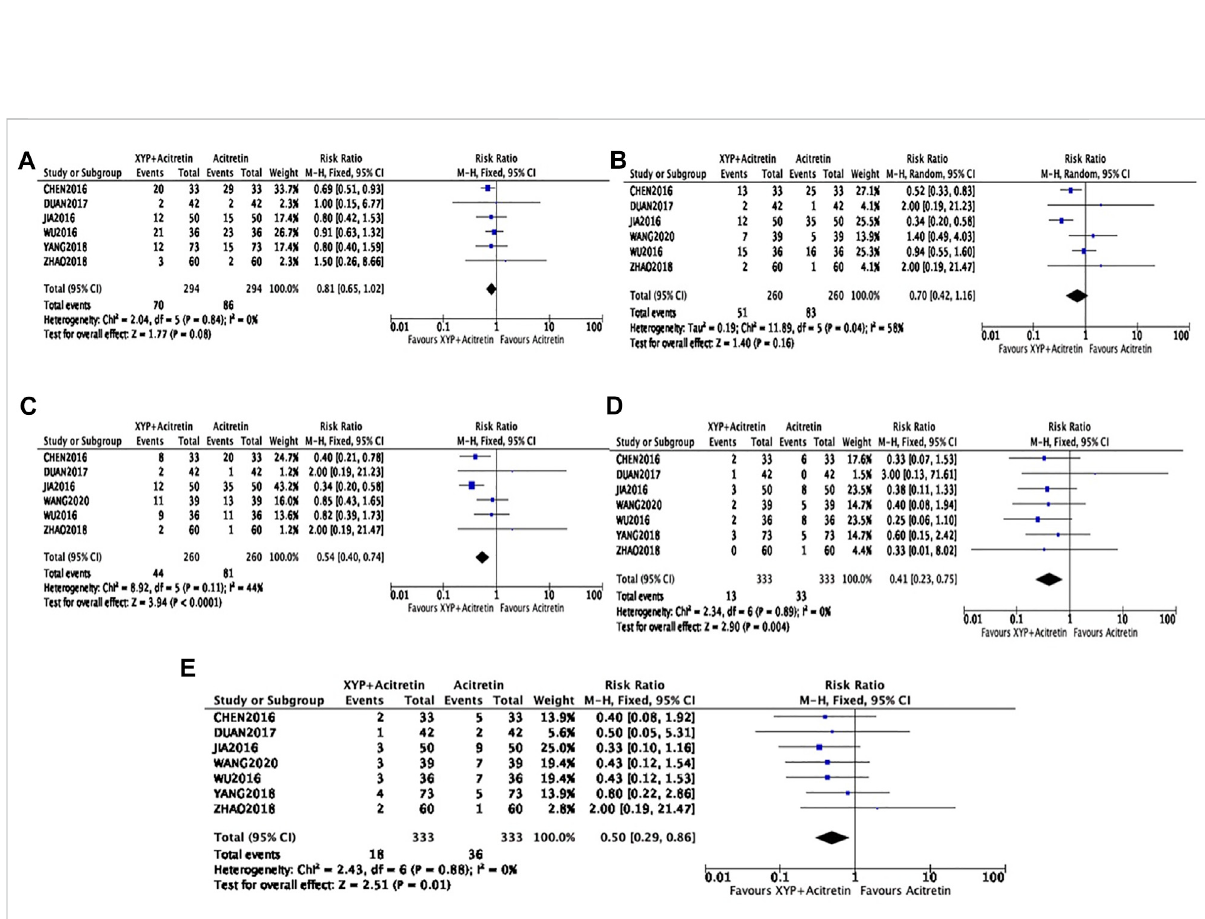
FIGURE 7 Forest plots showing side effects. Dry mouth: (A) ; Dry skin: (B) ; Itchiness: (C) ; Dyslipidemia: (D) ; Elevation of aminotransferases: (E)